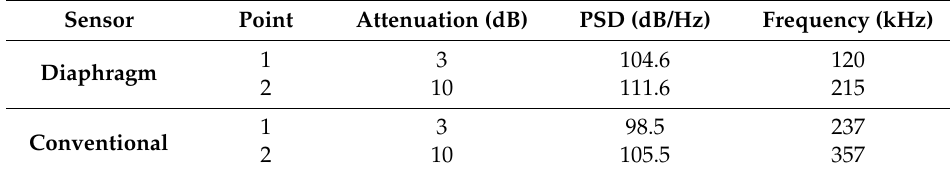
Figure 5. PSD obtained for the piezoelectric diaphragm (buzzer) and the conventional AE sensor. Table 1. Attenuation and frequency of the points highlighted in Figure 5.